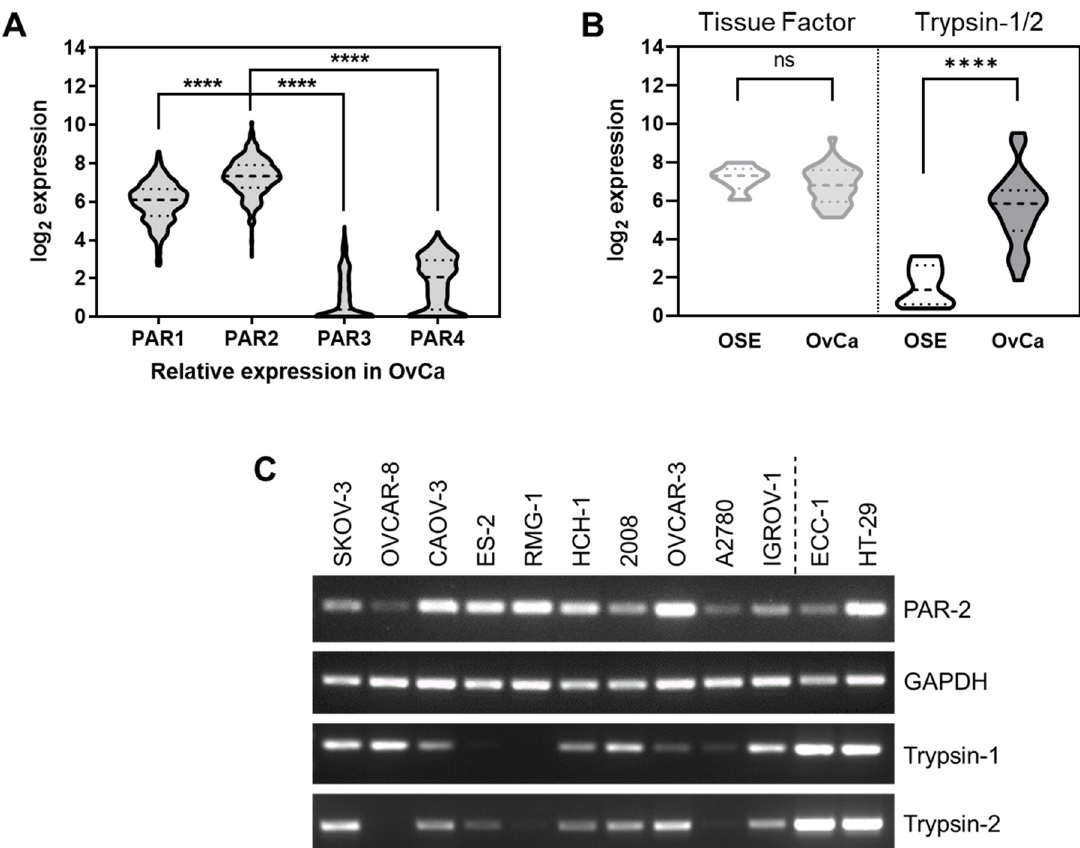
Fig 1. PAR2 and trypsin expression in ovarian cancer. (A) Relative gene expression of PARs in ovarian cancer was analyzed using the TCGA dataset (Tumor Ovarian Serous Cystadenocarcinoma-TCGA-527-MAS5-htu133a; N = 509); ���� : p < 0.0001: unpaired t test (PAR2 vs. PAR1) or Welch’s t test (PAR3 vs. PAR2; PAR4 vs. PAR2); Violin plot: median (dashed line); quartiles (dotted line). Similar results were obtained from other ovarian cancer datasets (Tumor Ovarian-Bowtell-285-MAS5.0-u133p2; Mixed Ovarian Cancer (CAFs)-Wong-77-MAS5.0-u133p2; Mixed Ovarian-Birrer-63-MAS5.0-u133p2); See S2 Fig. (B) Tissue distribution of PAR2 activating factors between ovarian surface epithelium and ovarian cancer tissues was analyzed from the dataset, which contains both tissue types; Mixed Ovarian Cancer (CAFs)-Wong-77-MAS5.0-u133p2 (OSE: microdissected ovarian surface epithelium, N = 6; OvCa: microdissected ovarian tumor epithelial component, N = 32); ns: not significant; ���� : p < 0.0001 (unpaired t test). Similar result was obtained from another ovarian cancer dataset (Mixed Ovarian-Birrer-63-MAS5.0-u133p2; See S2 Fig). (C) Expression of PAR2 and trypsin-1/2 in ovarian cancer cell lines was determined by semiquantitative RT-PCR. Expression of GAPDH served as a loading control; ECC-1 (endometrium) and HT-29 (colon) cancer cells were included as a positive control. dose-dependent (Fig 2E) and time-dependent activation of ERK in OVCAR-3 cells (Fig 2F) while a PAR2 knockdown attenuated the activation of ERK by trypsin or SLIGKV (Fig 2G). The effects of trypsin degradation on cancer cell proliferation Self-degradation of trypsin is well-studied [30]. To determine its half-life (T ) under our 1/2 experimental condition, we incubated trypsin in Dulbecco’s Modified Eagle Medium at 37˚C for different durations, after which trypsin expression was analyzed by SDS-PAGE electropho- resis with silver staining. We found that T for trypsin was 122 minutes (Fig 3A). The effects 1/2 of trypsin degradation on cell proliferation was then assessed. When OVCAR-3 cells were stimulated with trypsin once and left for further incubation for three days, we detected only a marginal increase in their proliferation (Fig 3B, at 17 nM) whereas daily stimulation for three days markedly enhanced the proliferation more than 40 percent (Fig 3B).